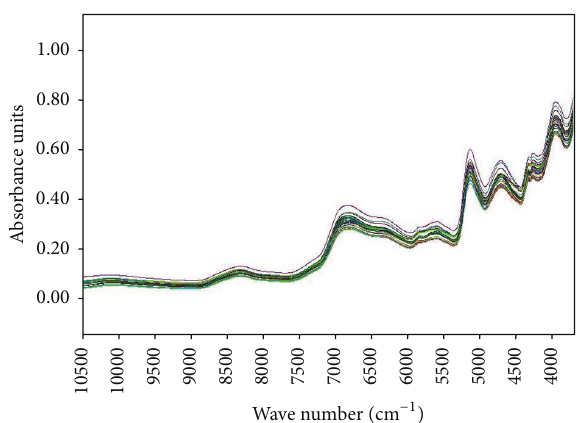
Figure 3: The original NIR spectrum of seven Fritillaria samples.